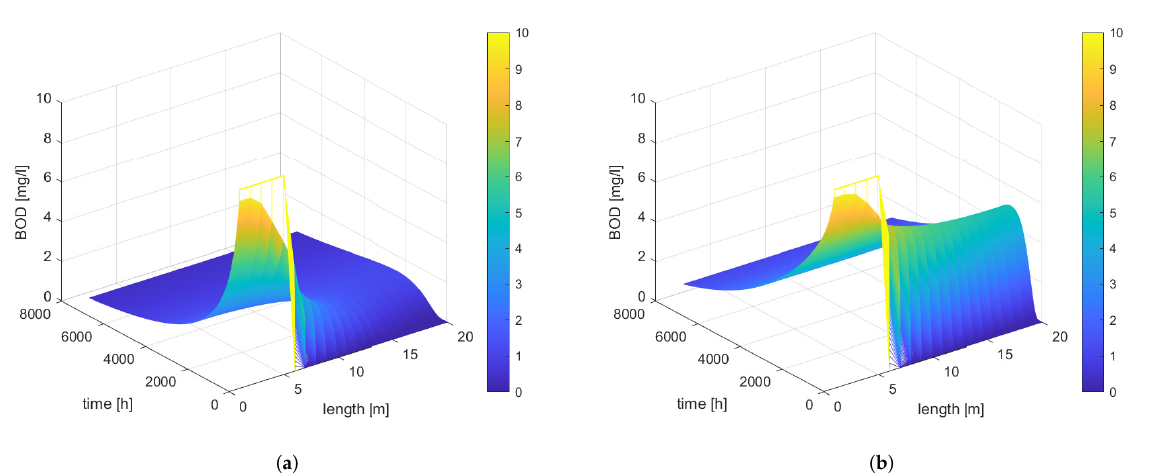
Figure 15. BOD distribution including diffusion for V = 0.001 ( a ) V = 0.01 ( b ) including the self-cleaning